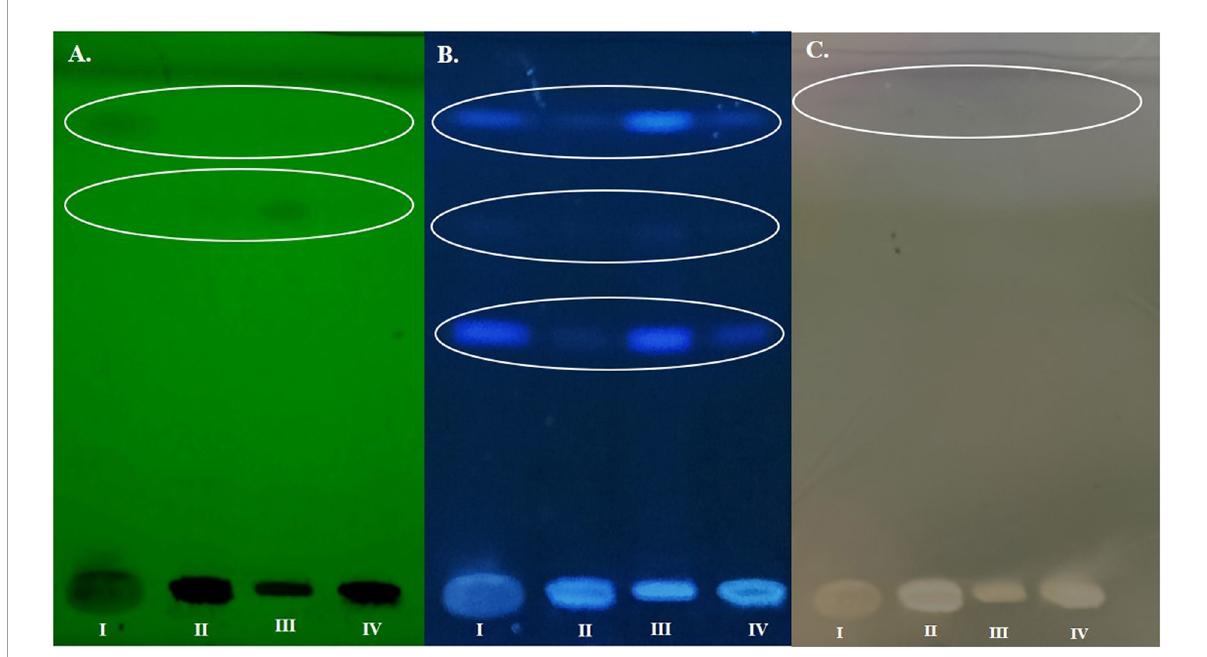
FIGURE7 HPTLC based characterization of the biosurfactant produced by MAPB-2 (I) MAPB-9 (II) MAPB-6 (III) and MAPB-27 (IV) under (A) 254 nm, (B) 366 nm, and (C) derivatized with anisaldehyde.